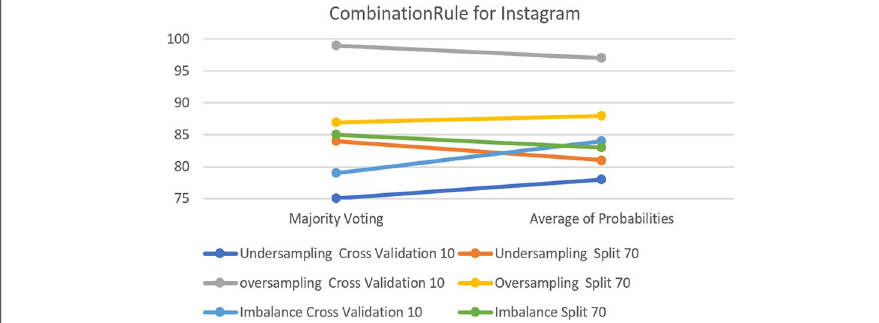
Fig. 22 The accuracy of CombinationRule for the Voting Classifier in